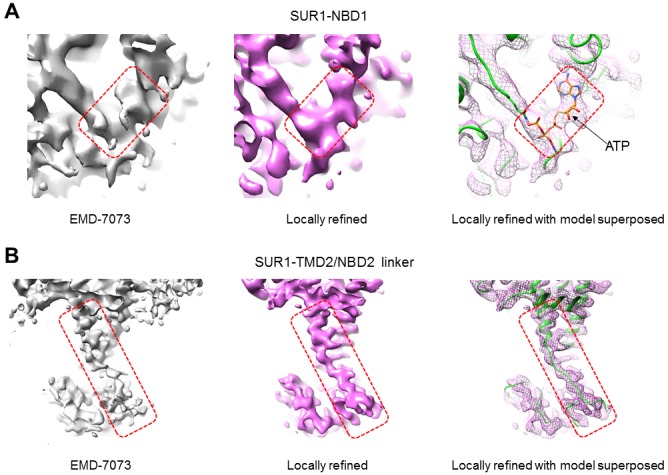
Comparison of the GBC/ATP state maps before and after focused refinement.(A) Left: Cryo-EM C4 map of the SUR1-NBD1 region published in Martin et al. (EMD-7073) contoured to 2.6σ; middle: the same region from the locally refined map contoured to 8.9σ; right: same as the middle panel except the density is displayed in mesh and the structural model of the protein and bound ATP are superposed. (B) Same as (A) but showing the linker region connecting TMD2 and NBD2.